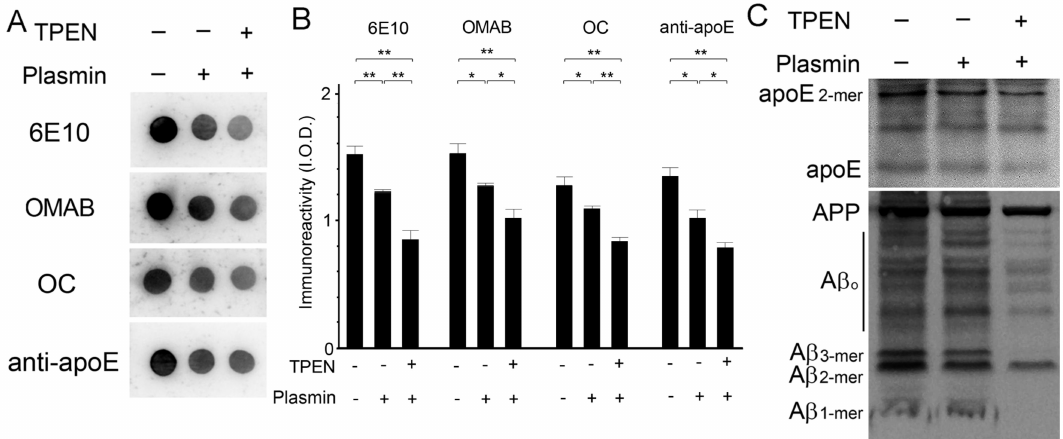
Figure 6. The e ff ects of zinc chelation on plasmin-induced apoE / A β degradation. Representative dot ( A ) and Western ( C ) blots for A β and apoE of brain lysates prepared in the same volume of bu ff er after the 30 min incubation with plasmin in the presence ( + ) or absence (-) of 100 µ M TPEN. ( B ) Quantitative measurements of apoE and total (6E10), oligomeric (OMAB), or fibril (OC) A β were performed in dot blots from whole brain tissue ( A ). The arbitrary integrated optical densities (I.O.D.) were measured. Data are from three independent experiments using brain lysates from the same Tg2576 mouse. * p < 0.05 and ** p < 0.01 by one-way